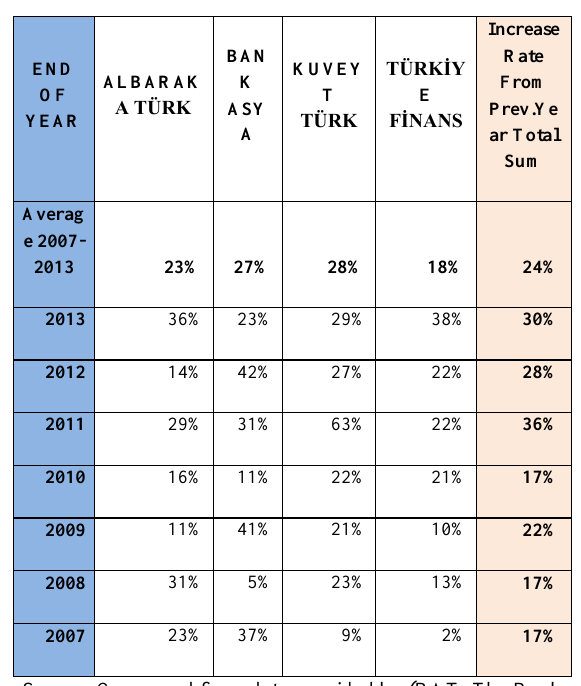
Table-7/b: Increase Rate from Previous Year at Foreign Currency Funds, 2007-2013